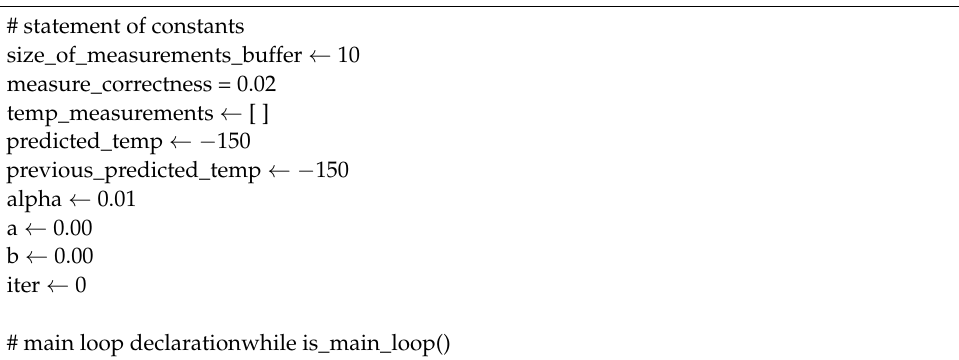
Algorithm 1 Temperature prediction